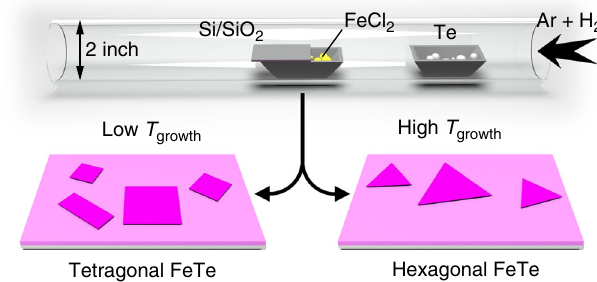
Fig. 1 Illustration of the experimental setup. The schematic view for the iron tellurides growth